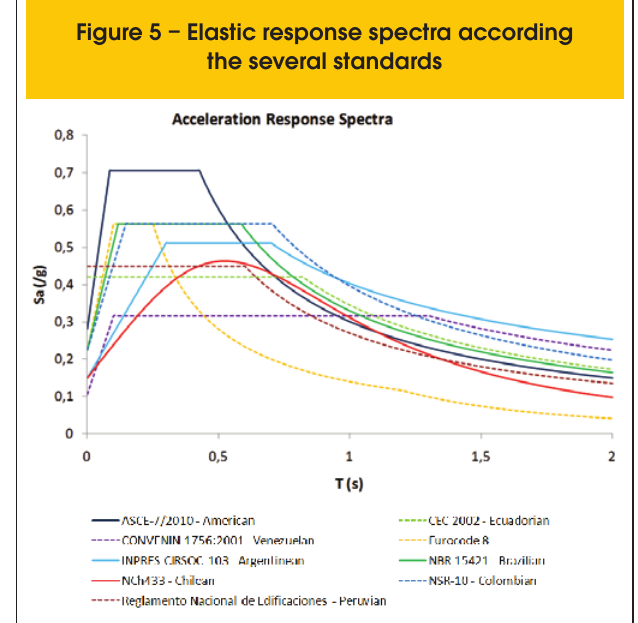
Figure 4 – Schematic perspective